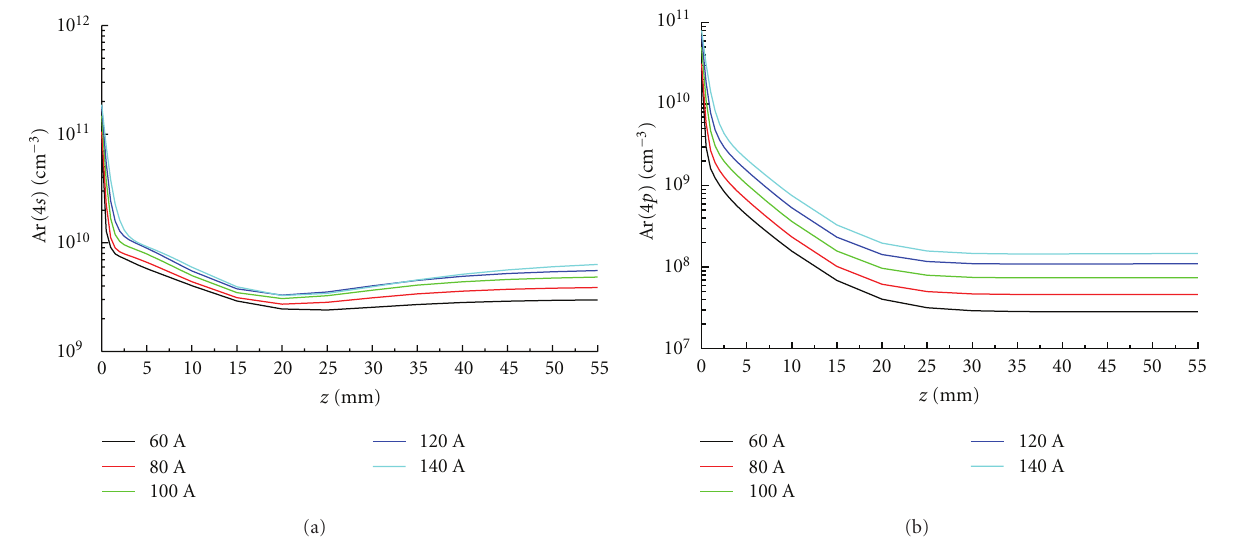
Figure 12: Populations along the divergent part axis of: Ar(4 s ), Ar(4 p ).